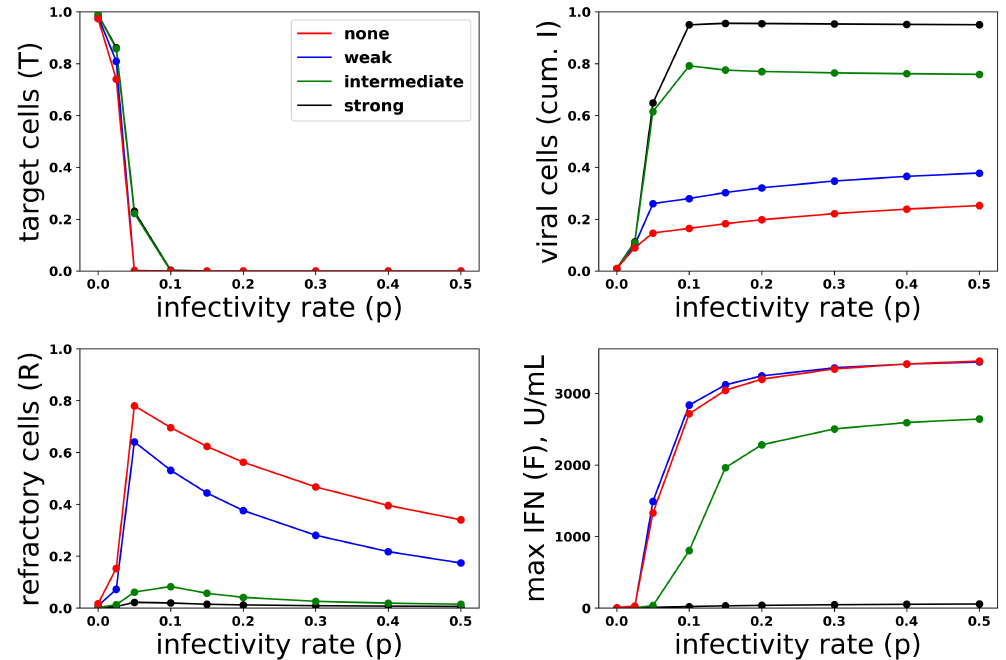
Figure 11. Viral antagonism of IFN induction leads to loss of protection and can block the IFN feedback loop. Colored curves correspond to different levels of viral antagonism of IFN: σ = 0, r = 0.3 (none), σ = 0.5, r = 0.2 (weak), σ = 0.95, r = 0.1 (intermediate) and σ = 0.99, r = 0.06 (strong). When viral antagonism is strong, extracellular IFN concentration stay low, reflecting blockage of the feedback loop, while for intermediate antagonism maximal, IFN concentrations rise to the significant level, but do not mediate protection. For other levels of antagonism, extracellular IFN concentrations reach high levels, reflecting activation of the feedback loop, and the IFN response mediates significant